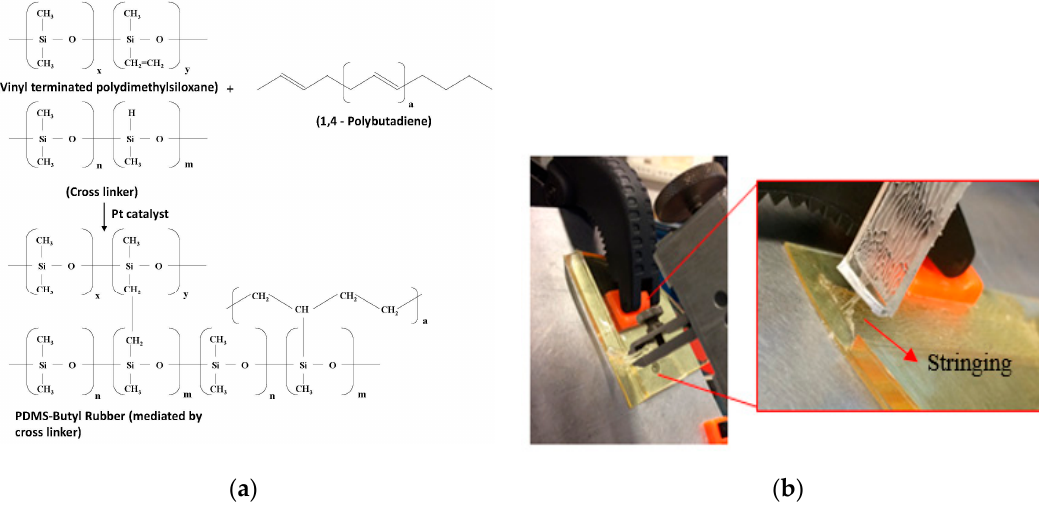
Figure 2. ( a ) Equation depicting the cross linking mechanism between PDMs and Butyl Rubber; ( b ) 90 ° peel measurement of PDMS from BR-PI interface depicting stringing effect